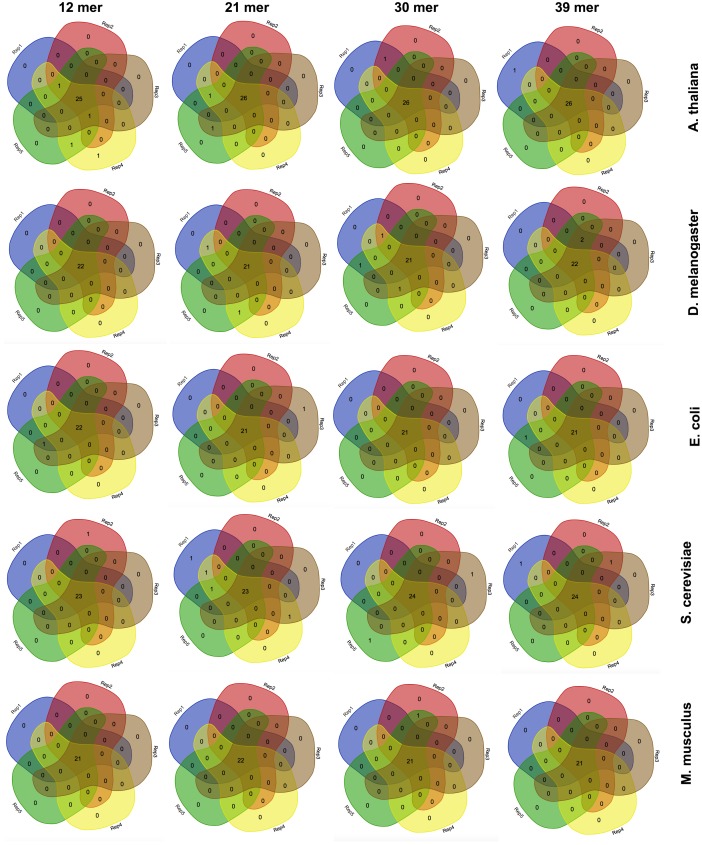
The effect of the k-mer size in the detection of favoured codons.Venn diagrams showing the number of detected favoured codons for five replicates, four nucleotide k-mer sizes and five species. For each presented diagram, each colour region reports the number of codons that were found to be favoured following a corseq run. Overlapping regions reports the number of concordant favoured codons between five replicates for the specified combination of species/nucleotide k-mer size.